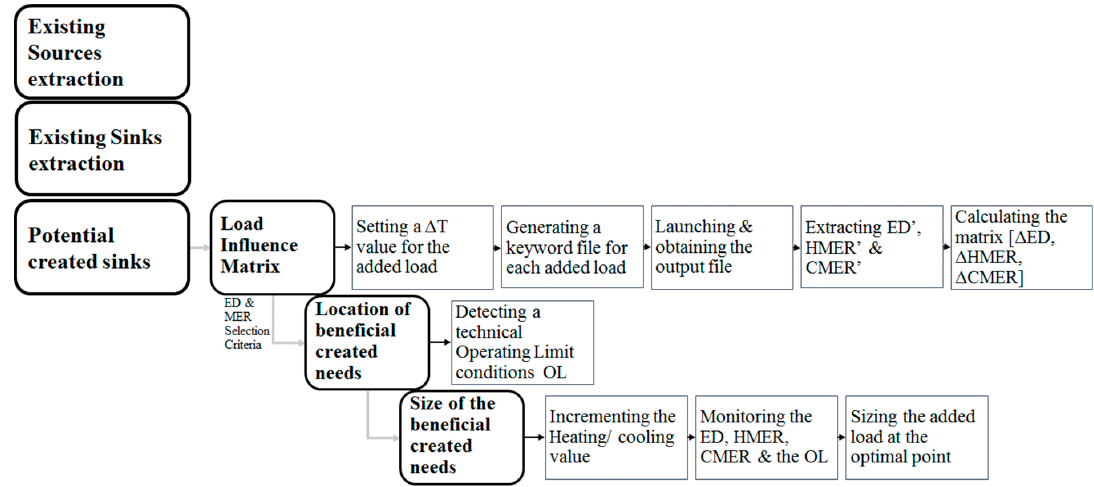
Figure 4. Steps of the sources/sinks identification unit.